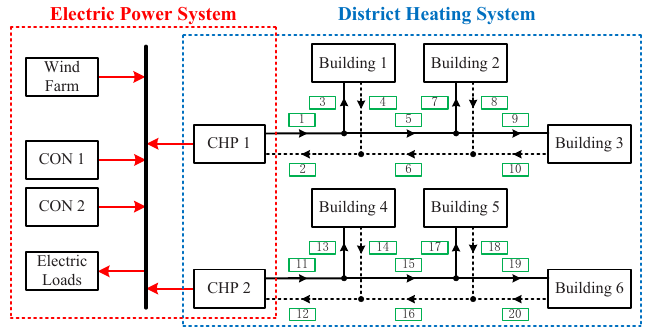
Figure 4. Configuration of the combined heat and power simulation